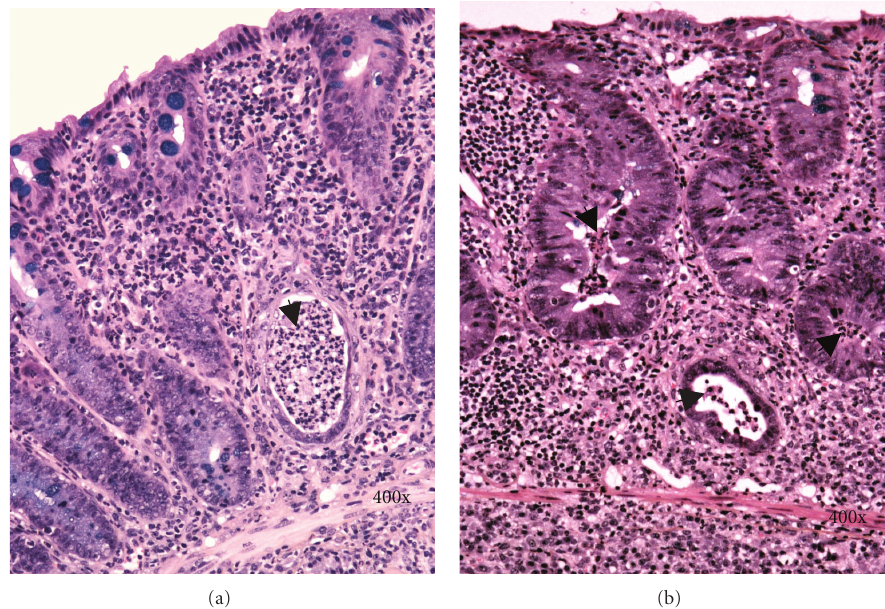
Figure 4: Arrows denote crypt abscesses (neutrophils) in the lumen of crypts. Kreyberg trichrom stain (acid mucopolysaccharides are stained blue). C57BL/6JOlaHsd male mice are exposed to 3% DSS solution for 5 days followed by drinking water for (a) 7 days and (b) 28 days.